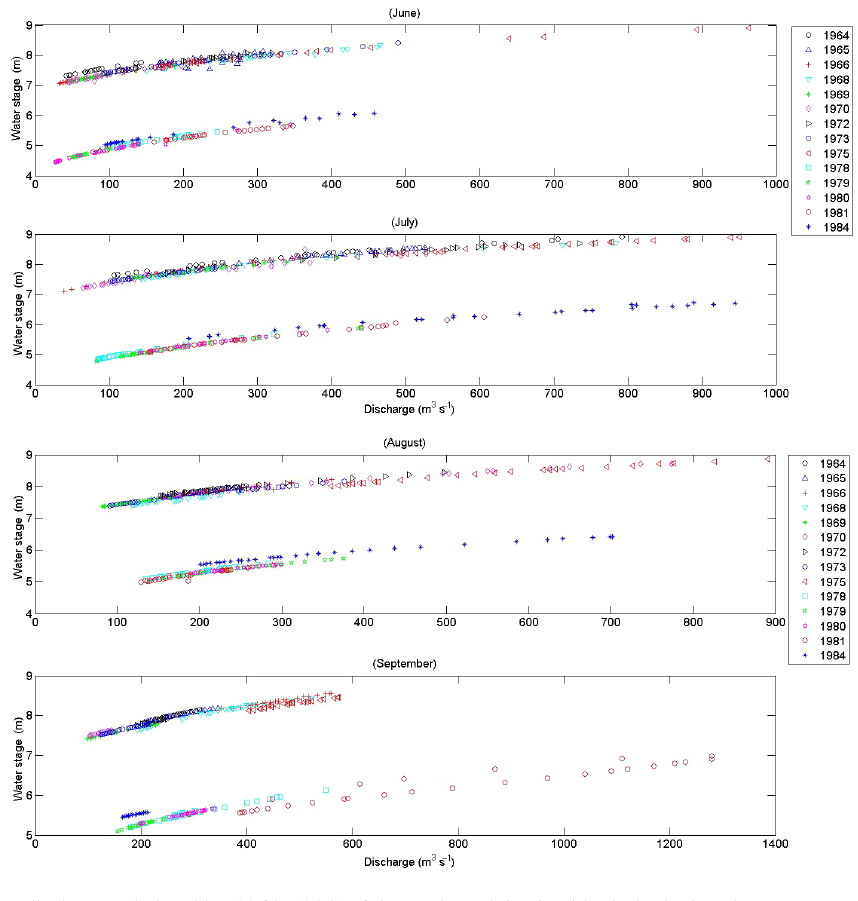
Figure 5. Annual stage–discharge relationship (1964–1984) of the Dari reach in Jimai hydrological station.